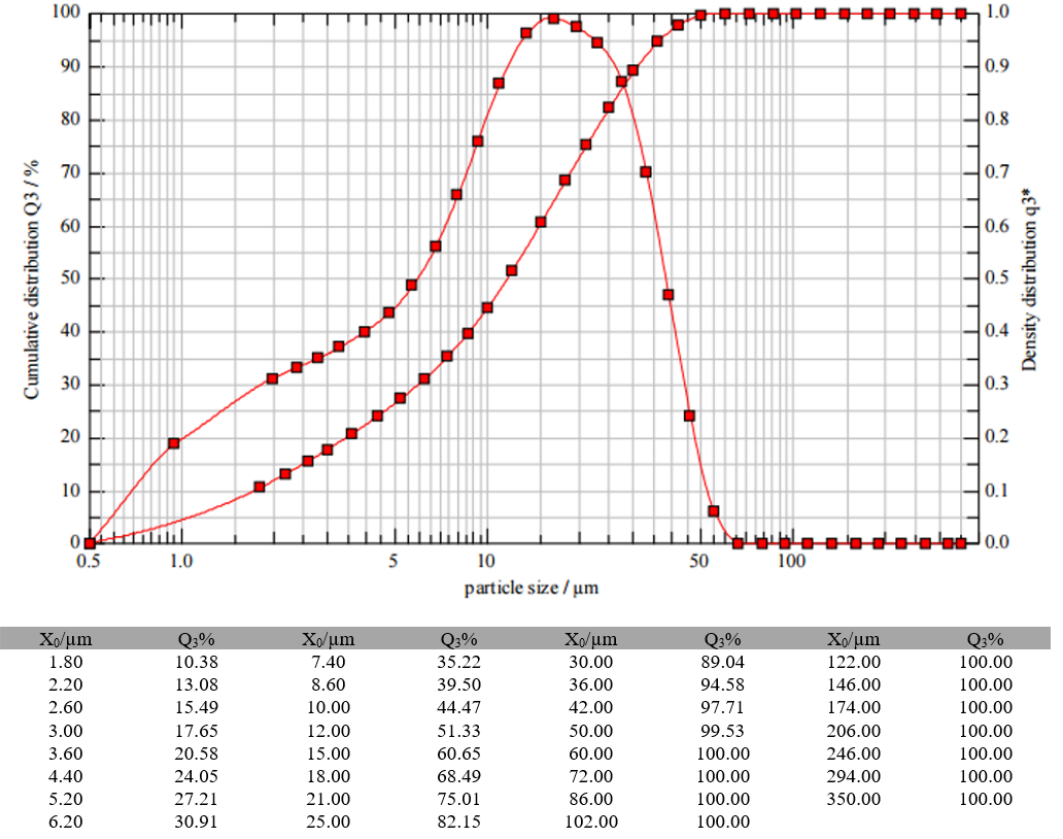
Table 1. Chemical composition of cement and GGBFS. Oxides